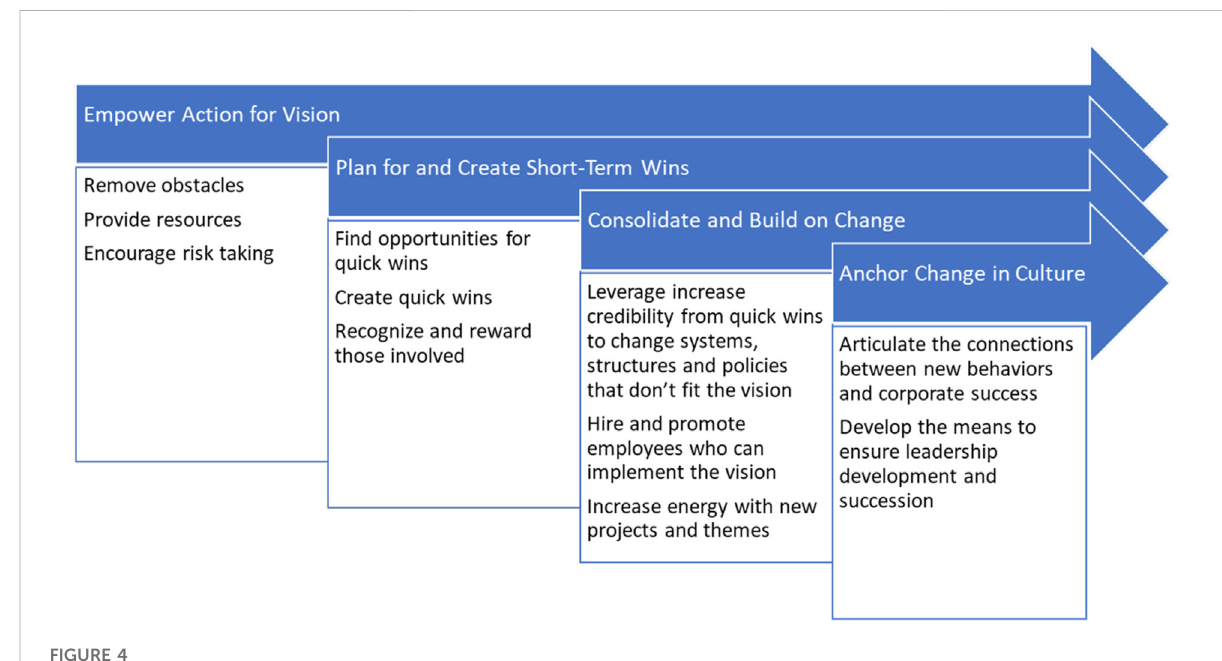
FIGURE 4 Model for executing the